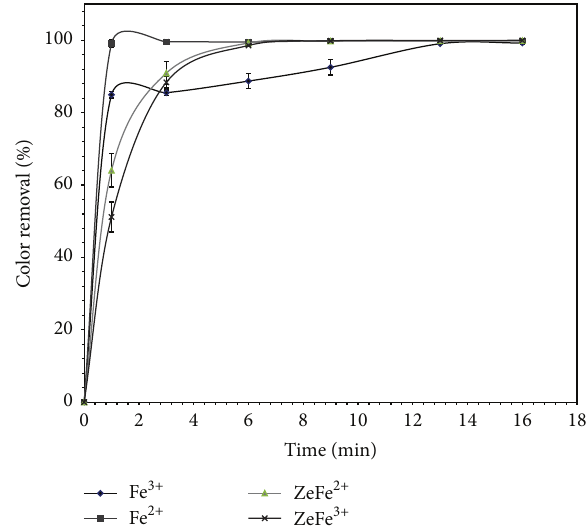
Figure 6: Color removal with time for the processes Fe 2+ /H 2 O 2 , Fe 3+ /H 2 O 2 , Fe(II)-Y zeolite/H 2 O 2 , and Fe(III)-Y zeolite/H 2 O 2 at optimized parameters.